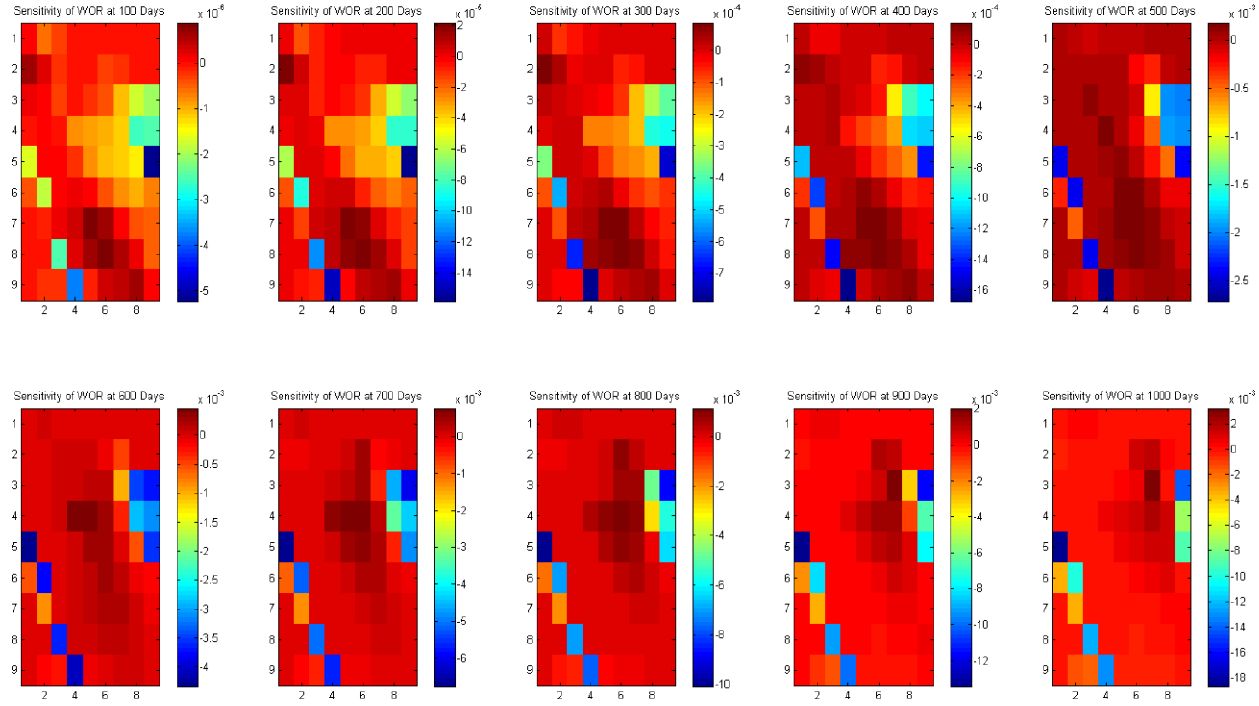
Figure 10—Sensitivity of